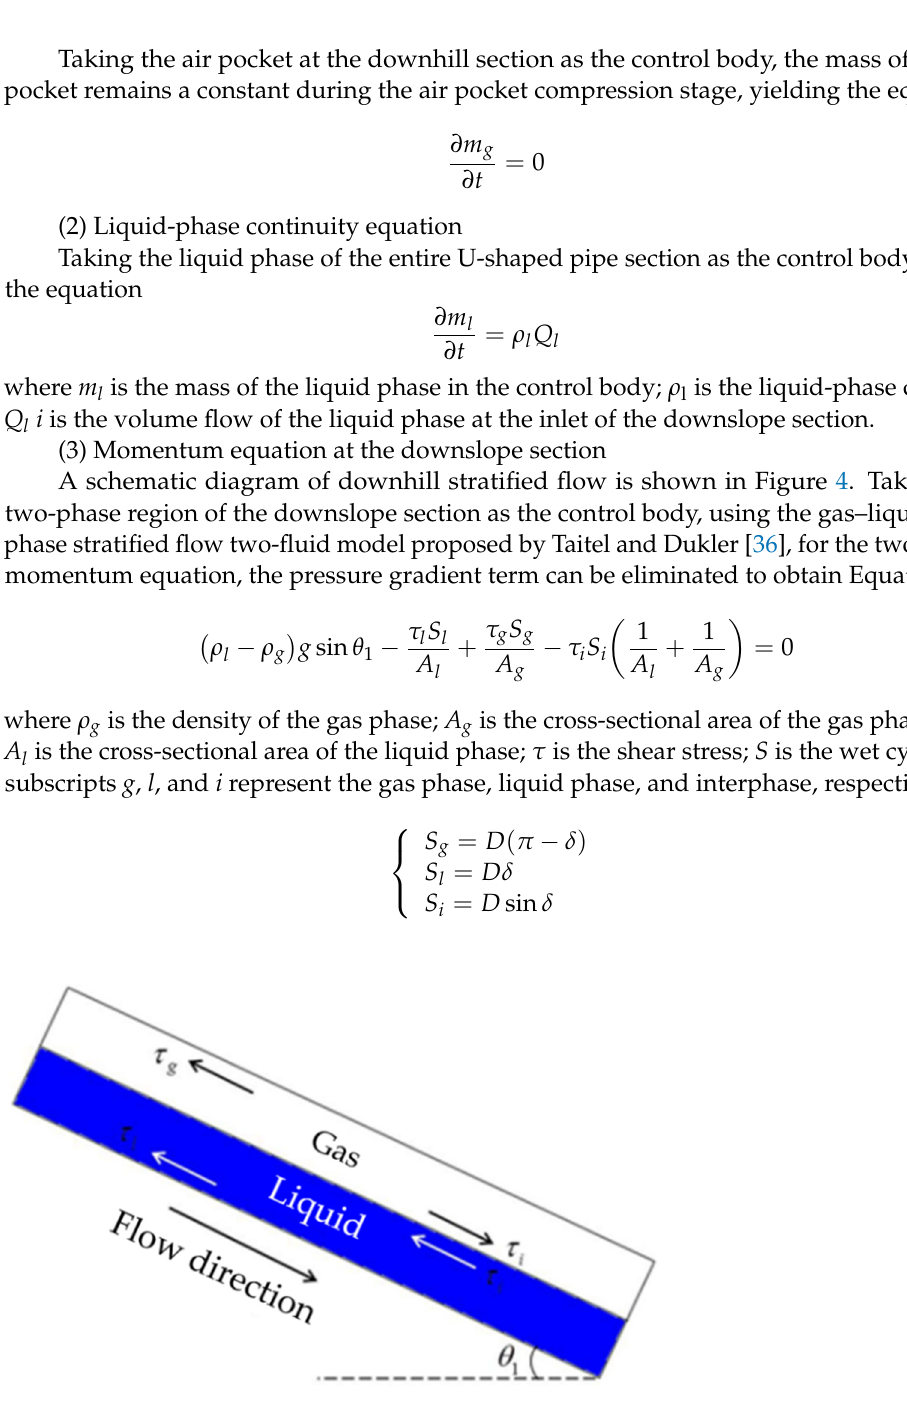
Figure 4. Schematic diagram of downhill stratified flow. shear force τ i ignores the interface